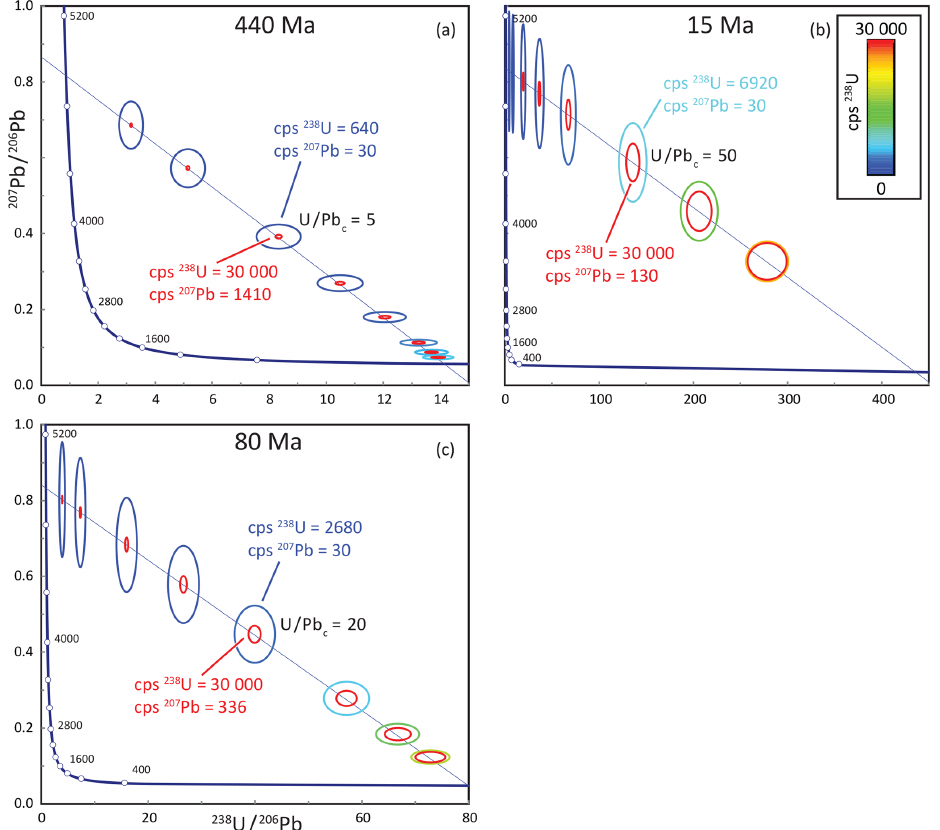
Figure 3. Uncertainty ellipses for each Tera–Wasserburg plot depict two end-member type of analyses in which the large ellipses represent the limit of detection of the all-Daly configuration, or any SC-ICPMS (limited by 207 Pb counts), and the smaller ellipses represent the uncertainty at 30000 cps 238 U, the point at which measurement of 238 U on the Daly is not advantageous. The ellipses are colored according to the 238 U count rate and depict the counting uncertainty for a 10s analysis at the given count rate and different U / Pb c ratios of 1, 2, 5, 10, 20, 50, 100, and 200. Example analyses are illustrated in each of the panels at different U / Pb c ratios of 5 (440Ma; a ), 20 (80Ma; c ), and 50 (15Ma; b